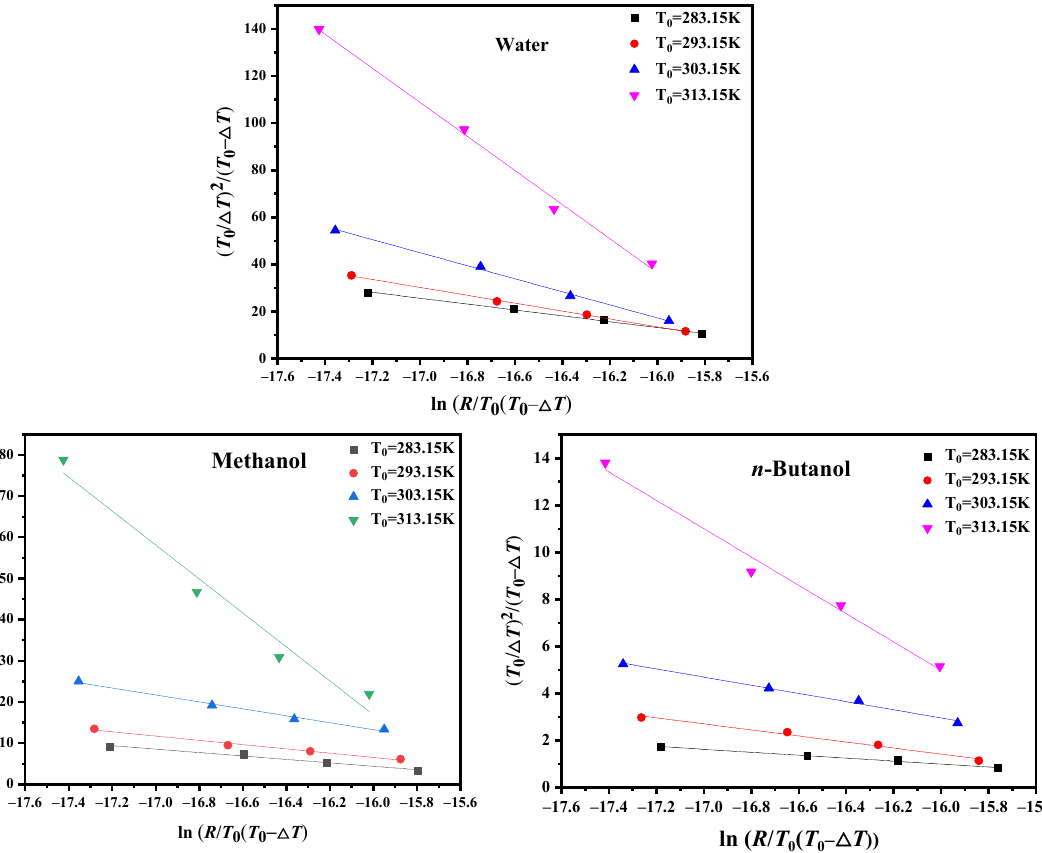
Figure 5. Relationship between MSZW and R at the given saturation temperature based on Equation (5) ( a )Water, ( b ) Methanol, ( c ) n -Butanol Table 4. Adipic acid intersects at a certain point at different temperatures.